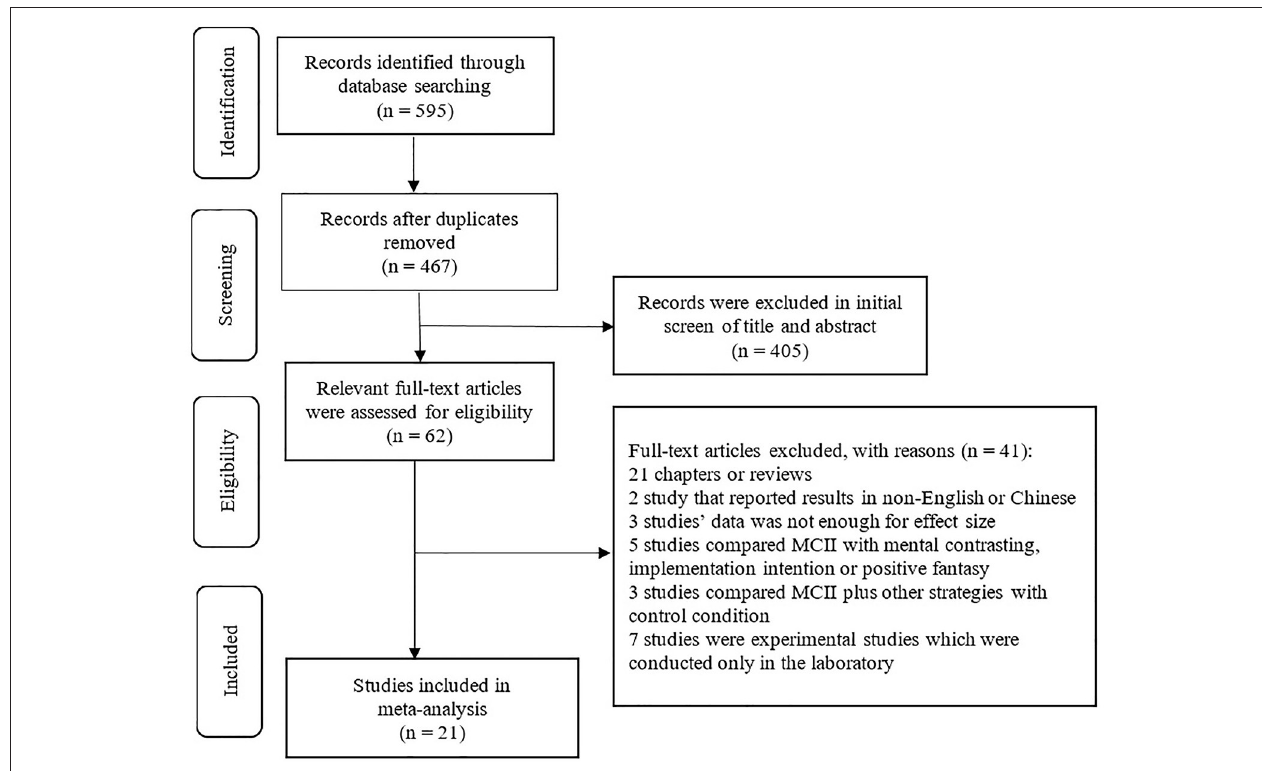
FIGURE 1 | Flow diagram of the literature search and study selection